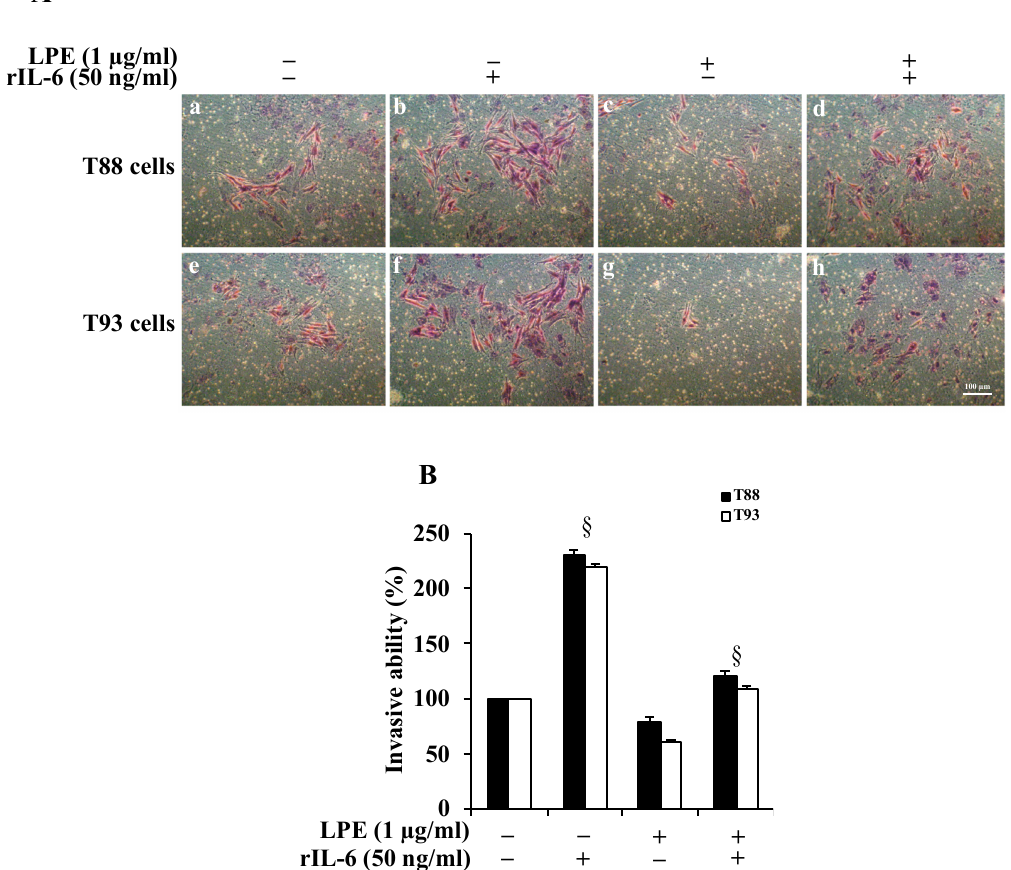
Figure 2. Effect of rIL-6 exposure with or without LPE pretreatment on the invasive ability of T88 and T93 cells. The cells were seeded in trans-well chambers for the Matrigel invasion assay, and then treated with rIL-6 alone ( b , f ), LPE alone ( c , g ), or pre-treated with LPE (1 µ g/mL GAE) for 6 h. Then, the medium was removed and replaced with the same amount of fresh medium containing rIL-6 (50 ng/mL) for 24 h ( d , h ). Control cells were kept in serum-free DMEM ( a , e ). Thereafter, the cells at the bottom of the filters were fixed, stained, and observed by a phase-contrast microscope (10 × objective). ( A ) Representative photomicrographs of random fields of T88 and T93 cells subjected to the different treatments. ( B ) The cell invasiveness was determined by the cell count in five fields, randomly selected, per membrane. Quantification was relative to untreated cells, cultured in serum-free DMEM, set at 100%. Results are presented as mean ± SD ( n = 3) (§ p < 0.01, statistically significant vs. untreated cells).